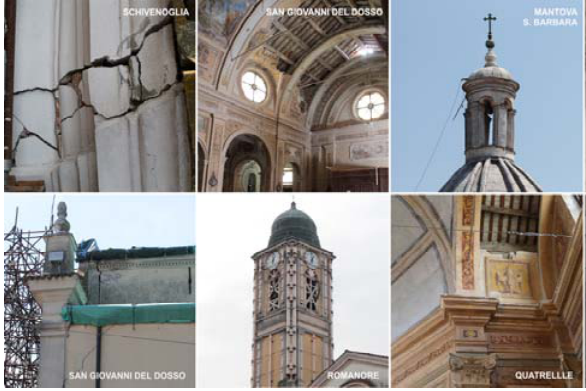
Figure 1: some photos of different damages in the churches of Diocese of